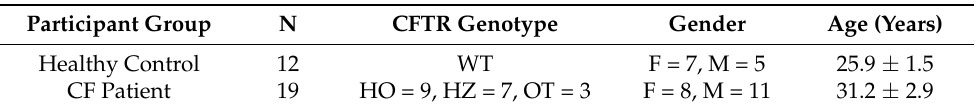
Table 1. Subject demographics. F, female; HO, patient with CF homozygous for F508Del mutations; HZ, patient with CF carrying one F508Del and one other mutation; M, male; OT: patient with CF carrying two mutations other than